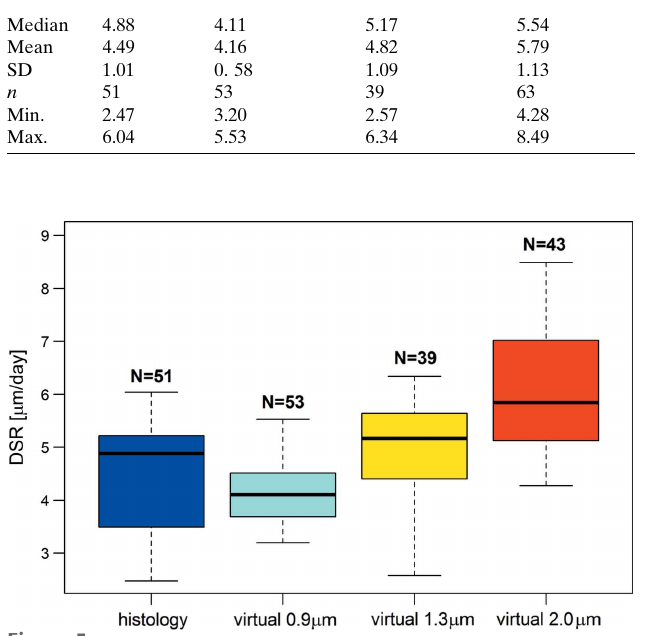
Figure 5 Box and whiskers plot of the DSR distributions in classical and virtual histology at different voxel sizes. Virtual 0.9: virtual histology at 0.9 m m pixel size. Virtual 1.3: virtual histology at 1.3 m m pixel size. Virtual 2.0: virtual histology at 2.0 m m pixel size. Bold line – median. N – number of samples.